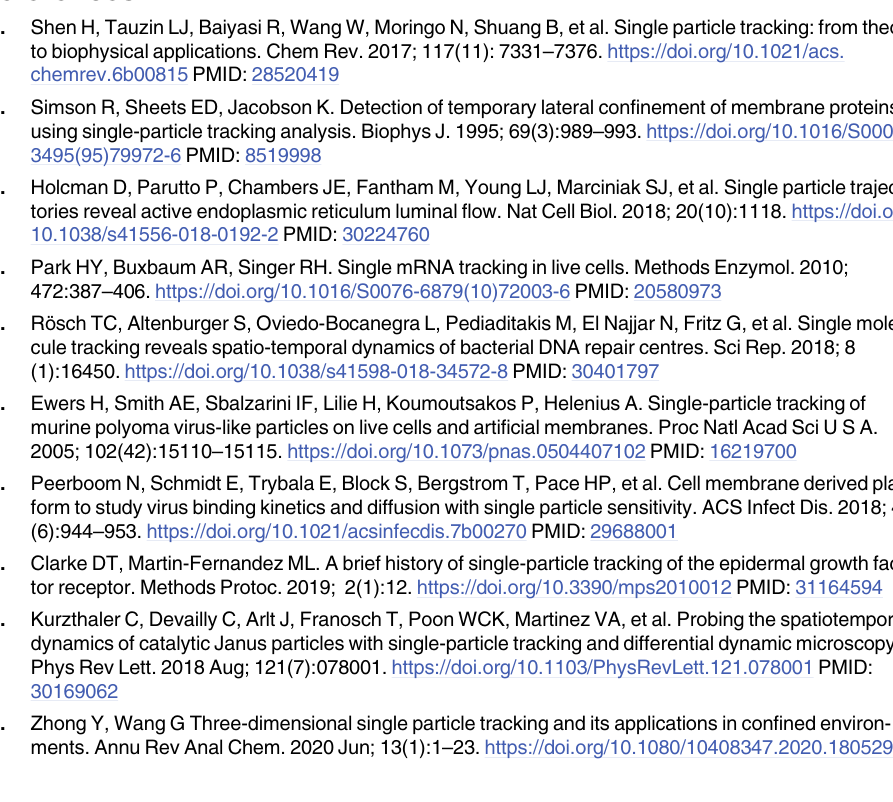
S1 Video. A typical video showing the relationship among trajectory, observation, and properties of readout noise brought by sCMOS. S1 Fig. Computation time record for different SPT